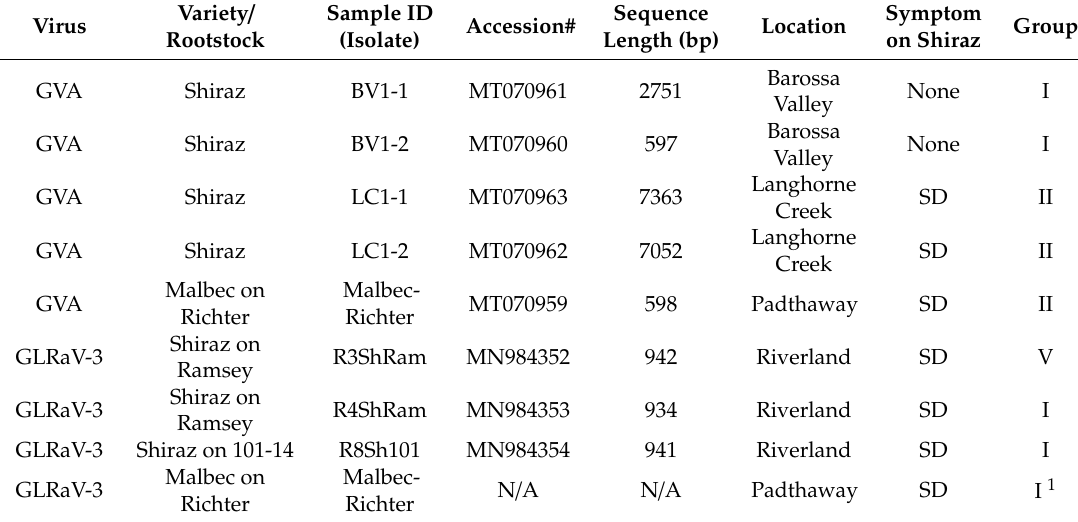
Table 5. Accession numbers of the Australian isolates of GVA and GLRaV-3 and their phylogenetic groups studied in this